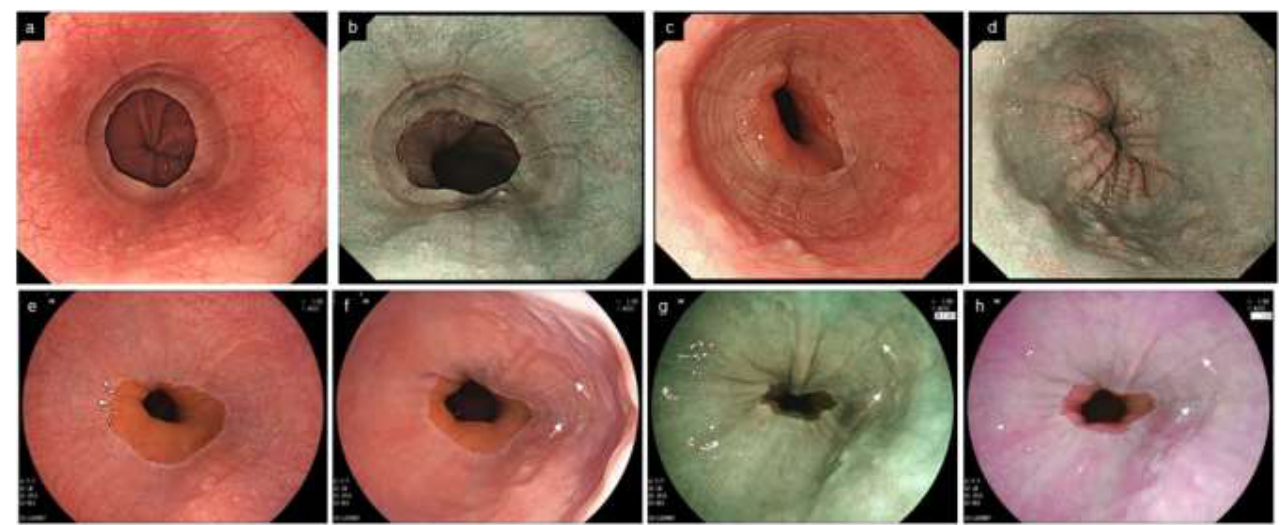
Figure 7. Other endoscopic findings related to EoE. ( a ). Multiple polypoid lesions ( b ). Ankylosaurus back sign ( c ). Tug sign/pull sign: with pulling by the biopsy forceps, a large amount of esophageal mucosa is lifted as a tent and caught in the forceps opening. ( d ). Caterpillar sign. EoE, eosinophilic esophagitis.